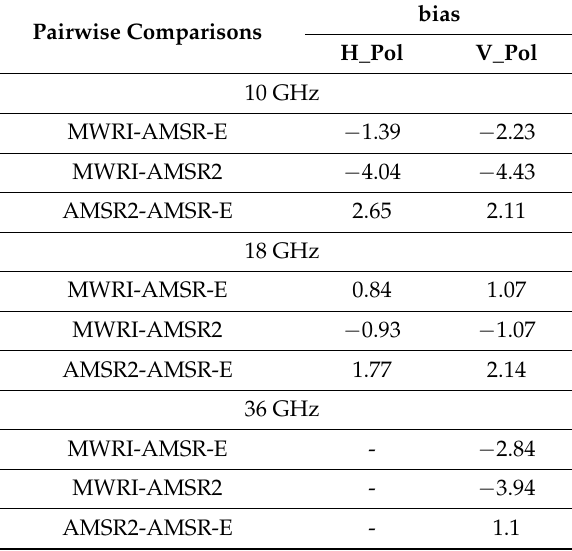
Table 1. Brightness temperature biases correction of advanced microwave scanning radiometer for